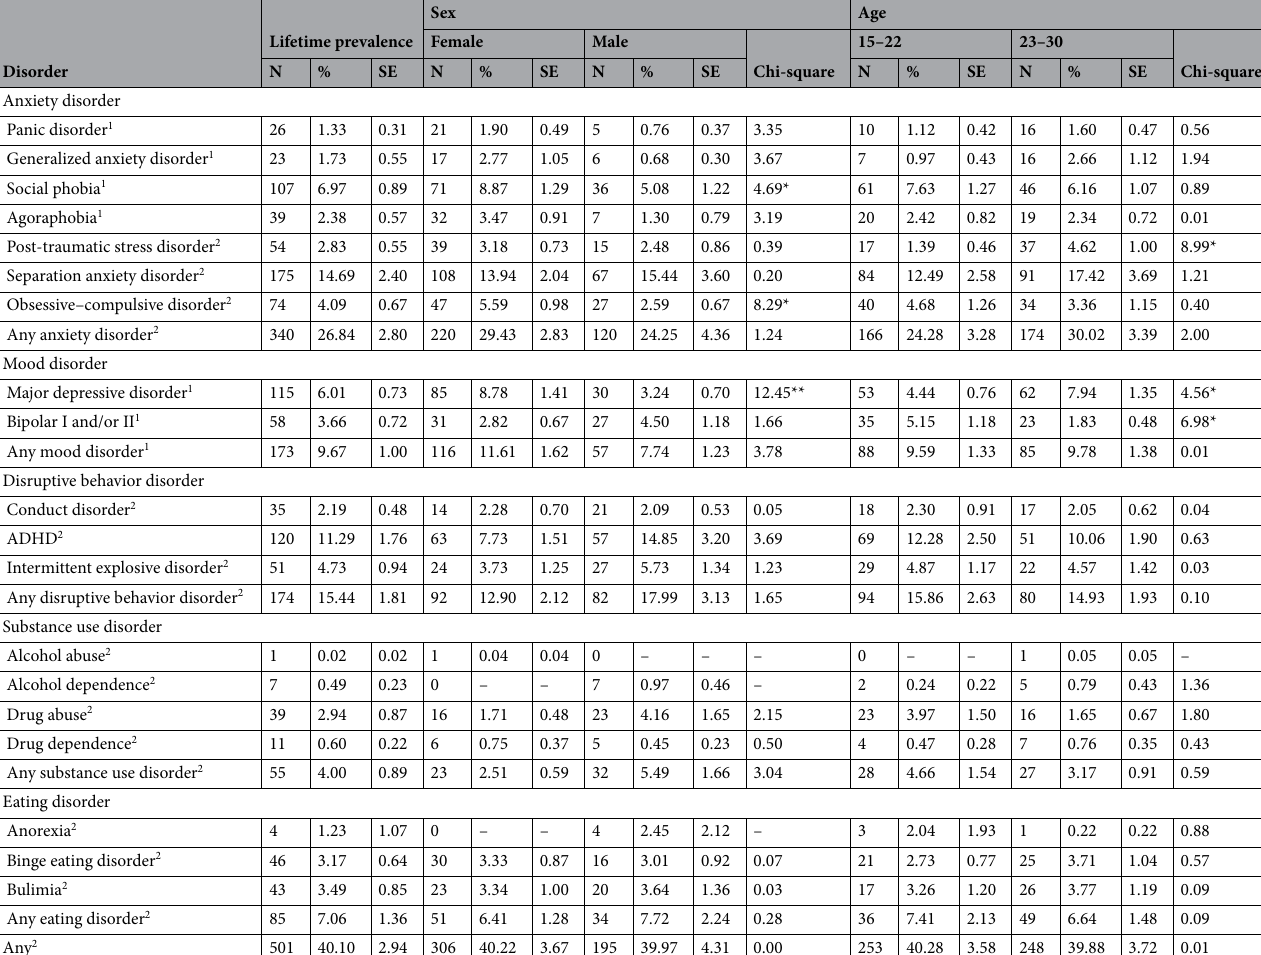
Table 2. Lifetime prevalence of DSM-IV/CIDI disorders, overall and stratified by sex and age in SNMHS youth. Part I sample, those who completed the survey (age 15–30) = 1811; Part II sample, those who